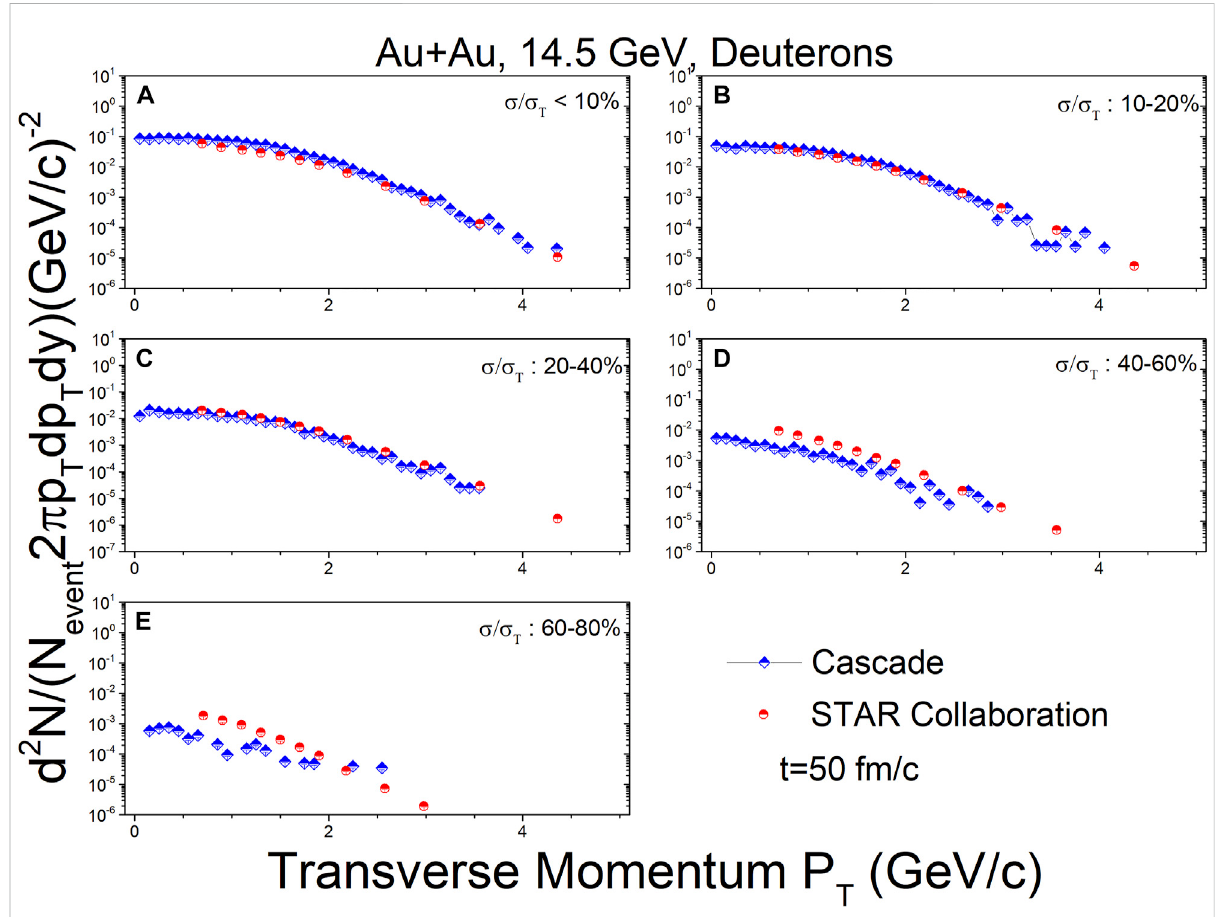
(cid:1)(cid:1)(cid:1)(cid:1) √ s NN In the = 14.5 GeV Au + Au collisions, 0, − ,10%, 10, − ,20%, 20, − ,40%, 40, − ,60% and 60, − ,80% centrality in t = 50 fm / c in the deuteron transverse momentum spectrum. Calculations are represented by signs + lines. Experimental data from the STAR collaboration [27] are represented as circles. The parameter sets of ( R 0 , P 0 ) is (3.8 fm, 0.3 GeV/ c